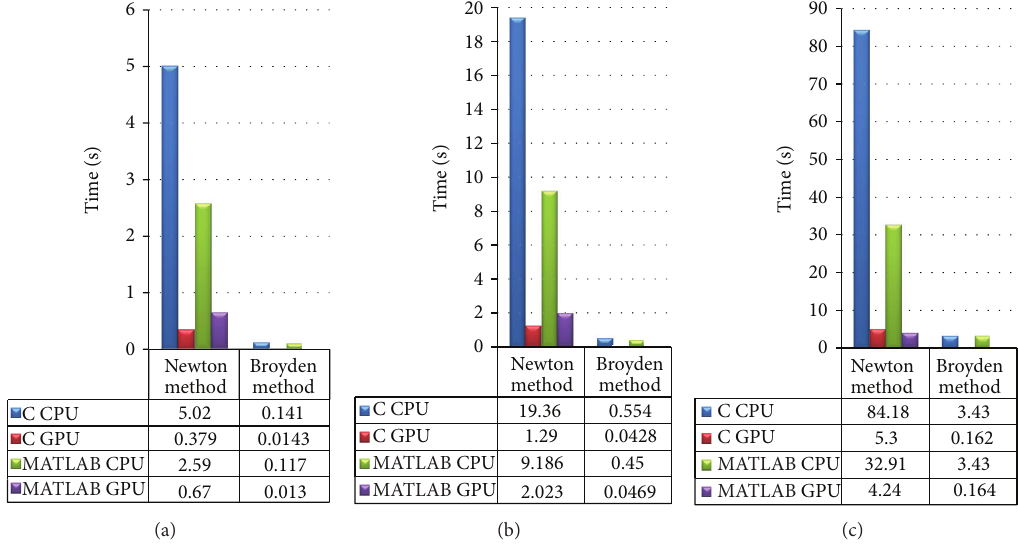
Figure 8: Execution time for Jacobian calculation by conventional and Broyden method on C CPU, C GPU, MATLAB CPU, and MATLAB GPU platforms for mesh size (a) 3736, (b) 7465, and (c)